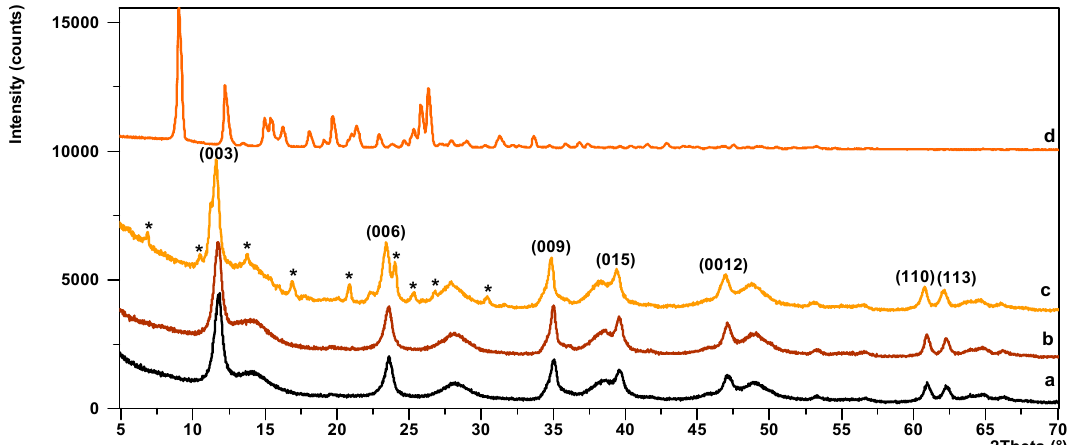
Figure 4. XRD powder diffraction patterns for (a) aluminum-magnesium hydroxycarbonate (LH), (b) HPD, (c) HPM, (d) MCD dye.